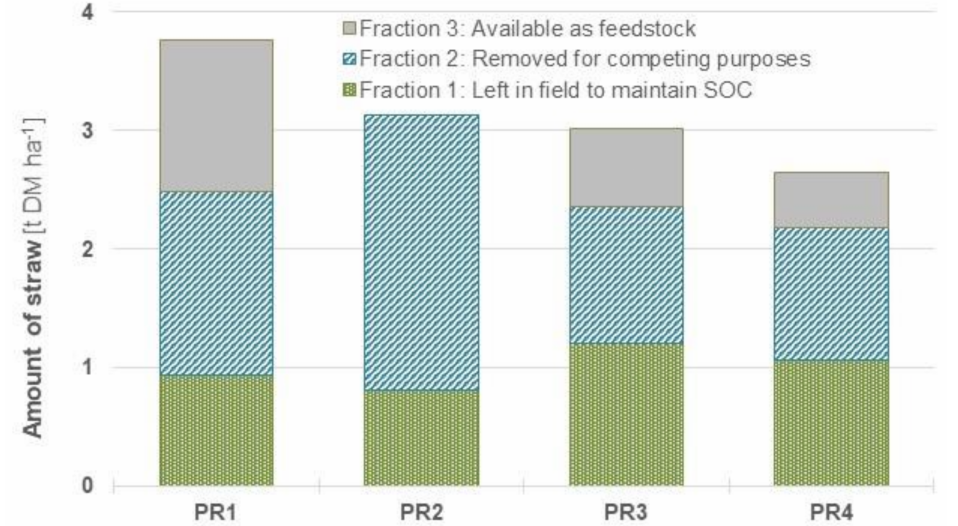
Figure 2. Distribution of straw fractions in the assessment of the different production regions